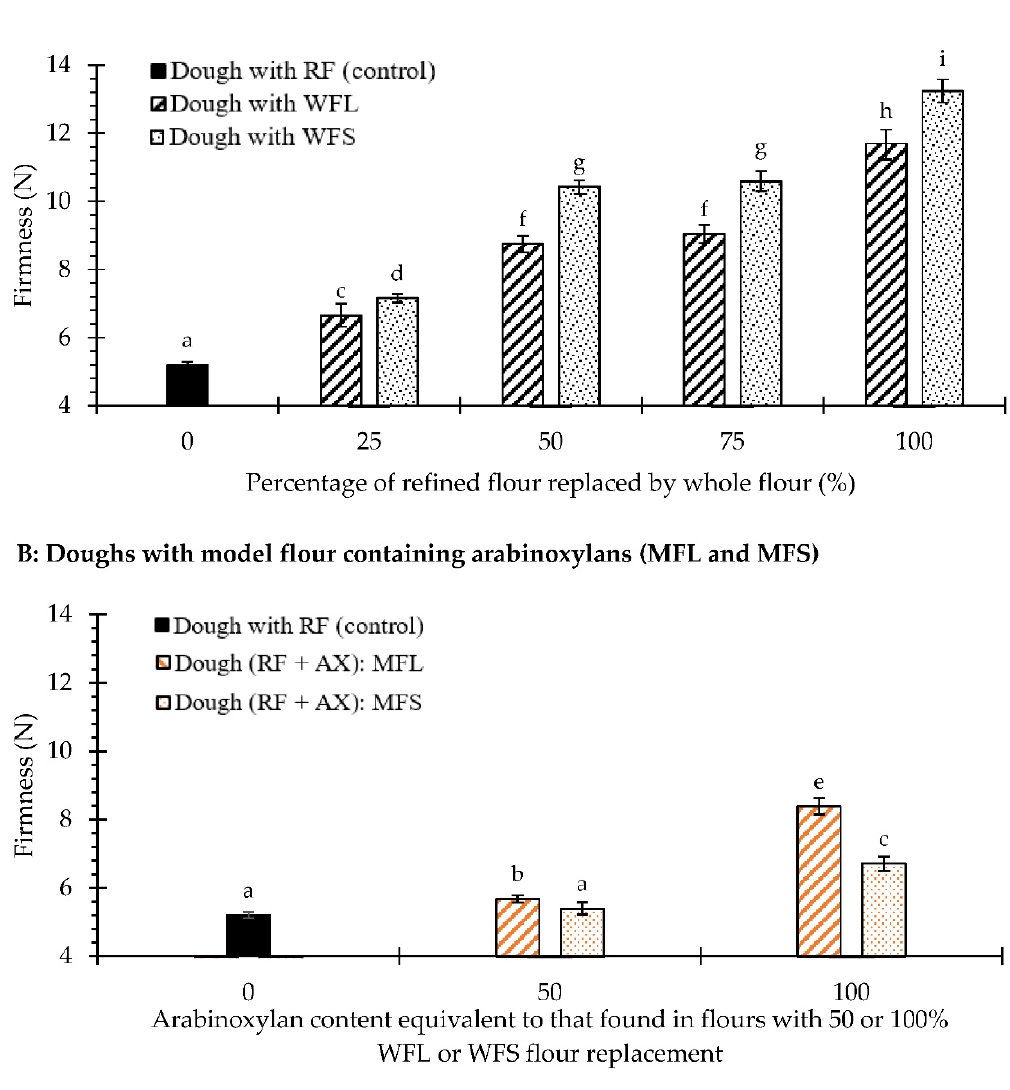
Figure 1. Firmness (N) of control dough, doughs prepared by replacing 25, 50, 75 or 100% of the refined flour with whole flour with coarse bran (WFL) or whole flour with fine bran (WFS) ( A ), and model flours enriched with arabinoxylan with an equivalent content to that found in flours with 50 or 100% whole flour replacement (MFL: coarse bran; MFS: fine bran) ( B ). Data are observed mean ± confidence intervals at 95%. Different superscript letters refer to significant difference ( p < 0.05).